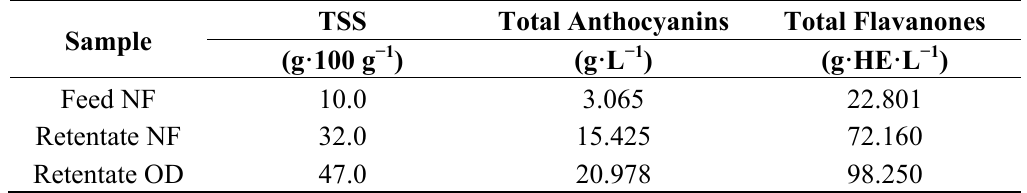
Table 5. Analytical evaluations of total anthocyanins, flavanones and TSS in samples of clarified liquor from NF-OD